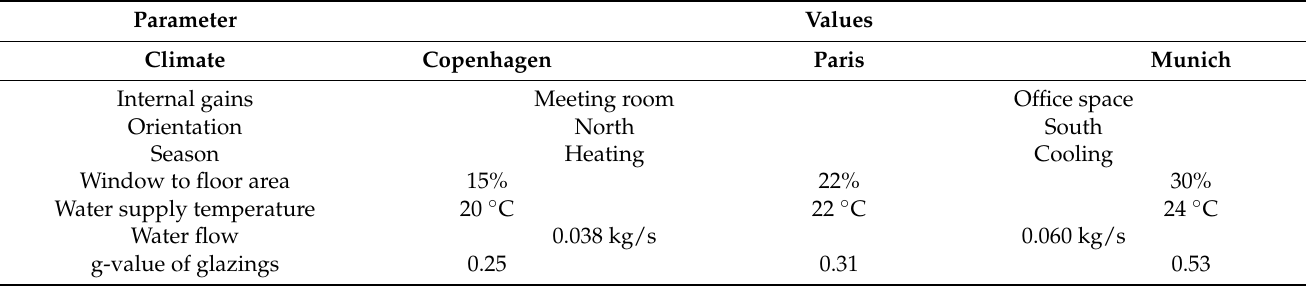
Table 3. Parametric study values used in IDA